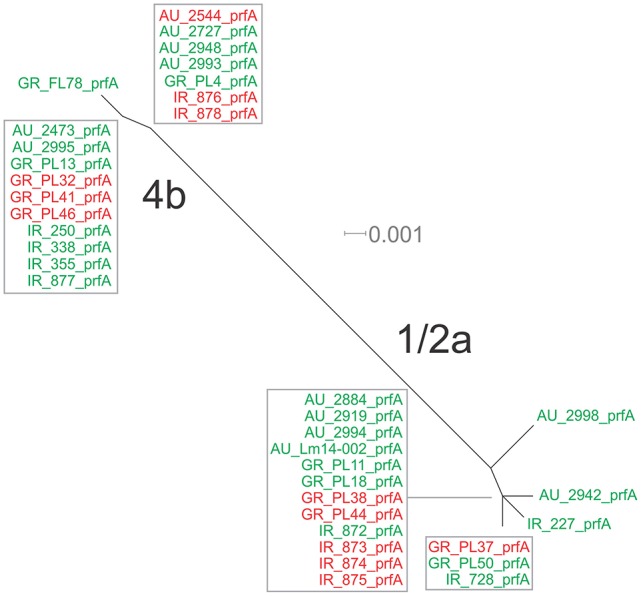
Phylogenetic network applied to virulence gene prfA using the Neighbor-Net algorithm. L. monocytogenes strains represented food environment isolates (green color) or clinical isolates (red color), isolated in Ireland (IR), Greece (GR), and Australia (AU). Strains clustered together in a box represent identical nucleotide sequence.